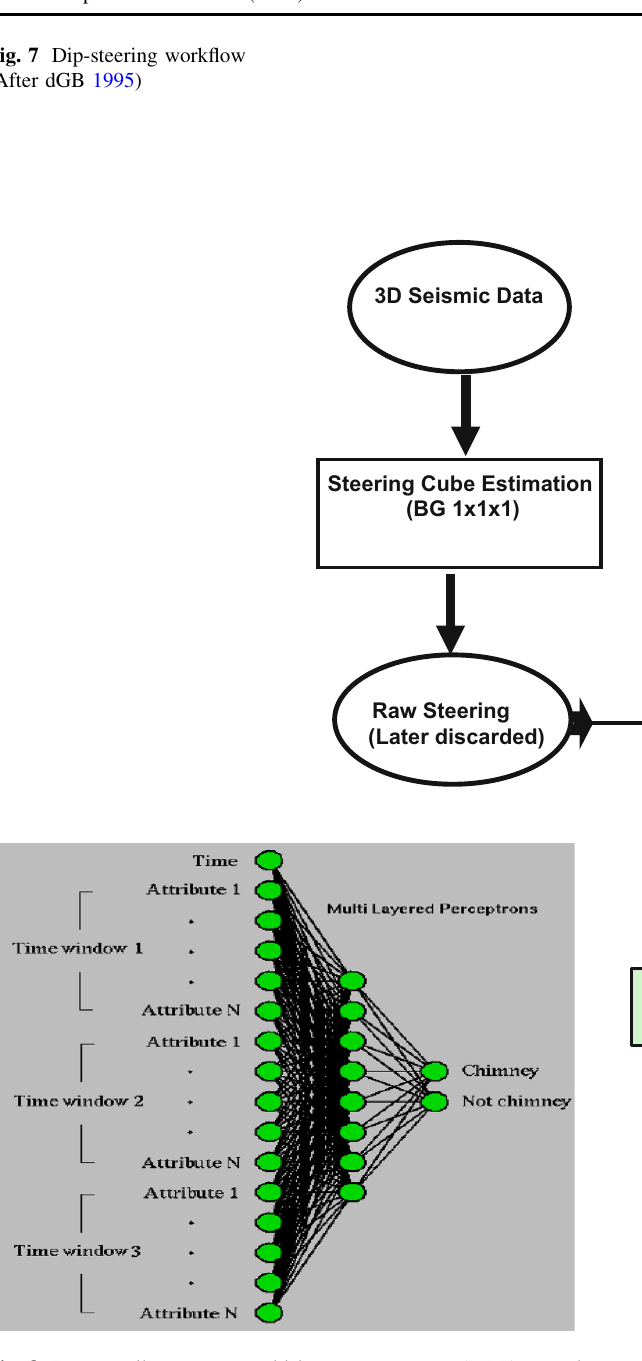
Fig. 8 Input attributes to a multi-layer perceptrons (MLP) neural network to obtain chimney probability Fig. 9 SCI method workflow (After Veeken and Da Silva,